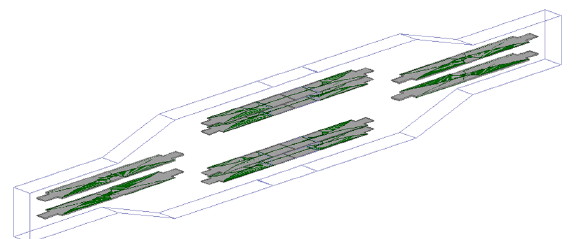
Figure 10: The SPC designed for the X band employing the broadband mode transformers.